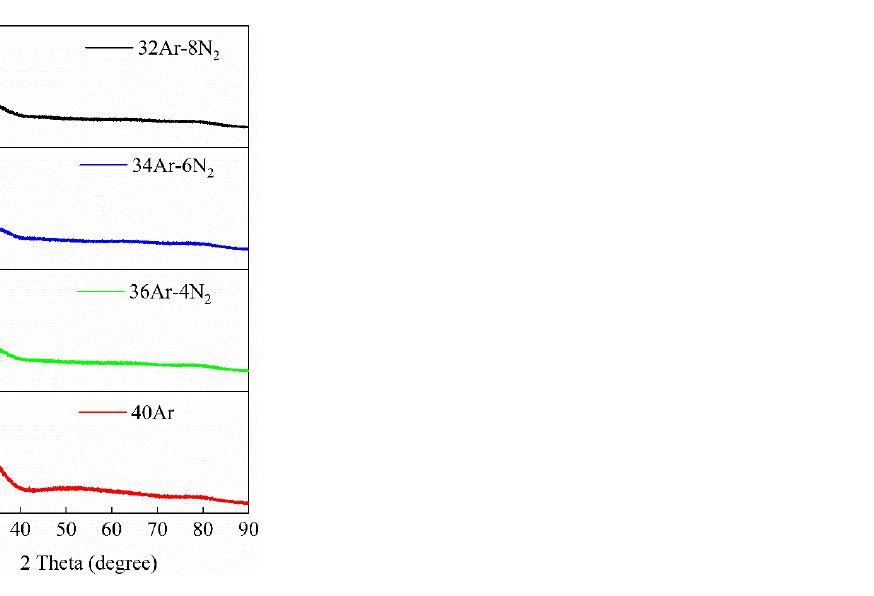
Figure 2. XRD spectra of Ta 2 O 5 coatings deposited at sputtering power of 140 W with different N 2 and Ar fluxes.